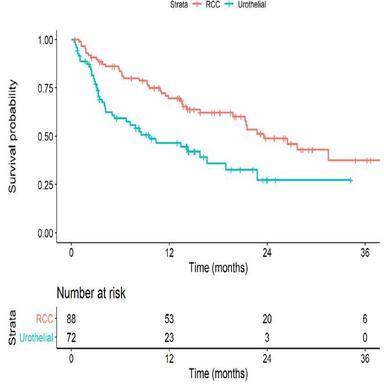
Kaplan-Meier curves of overall survival stratified by GU malignancy subtype. GU = genitourinary; RCC = renal cell carcinoma.